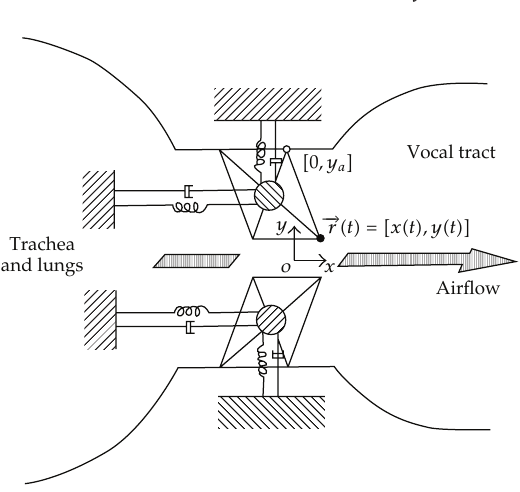
Figure 2: Two-degrees-of-freedom one-mass model of the vocal cord (cid:4) 11 (cid:5)